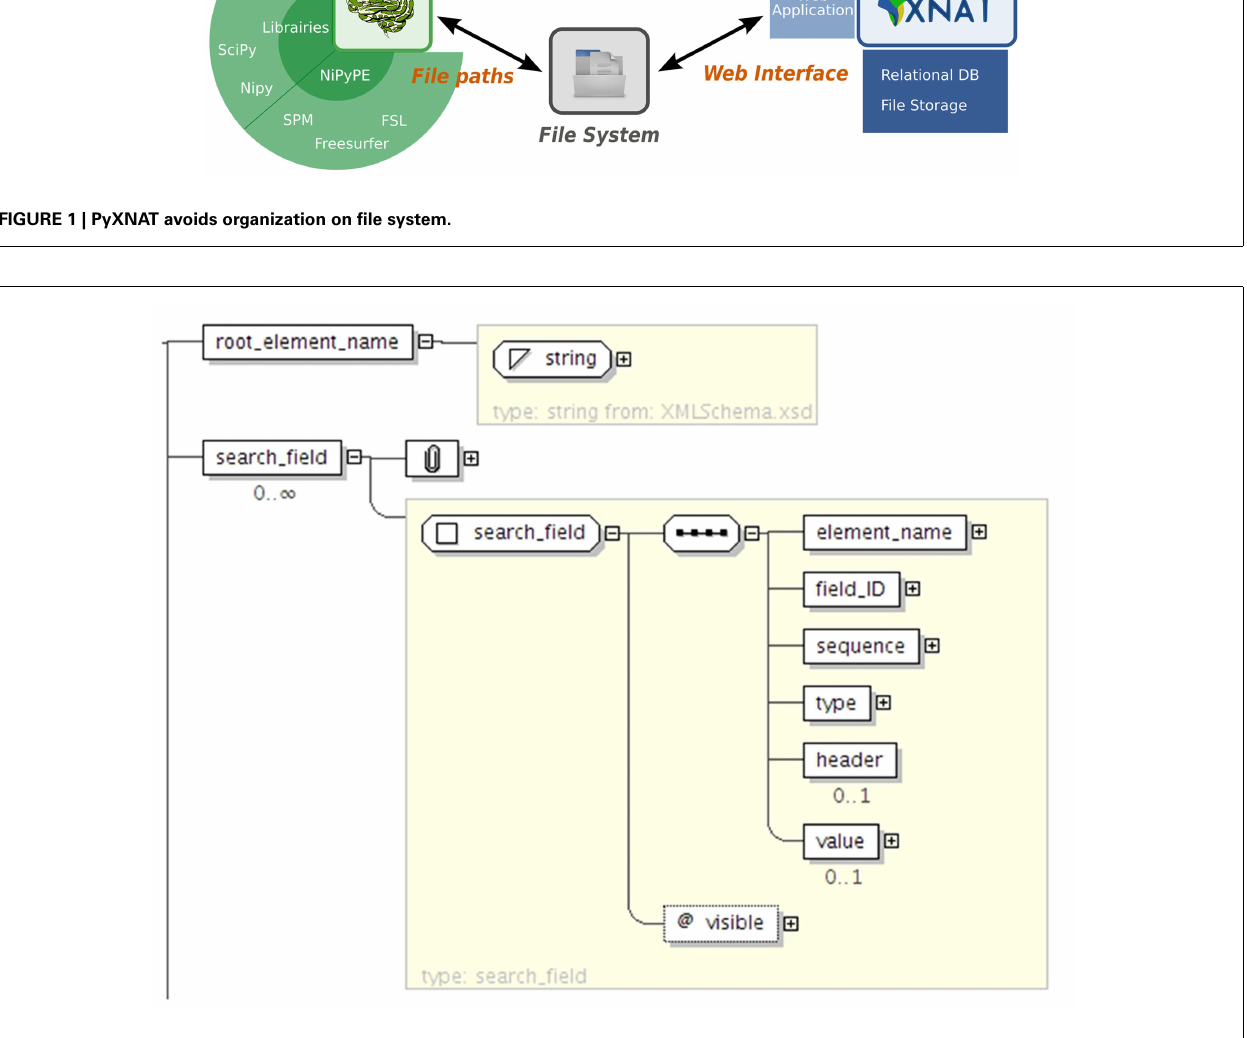
FIGURE 2 | XML Schema for the result